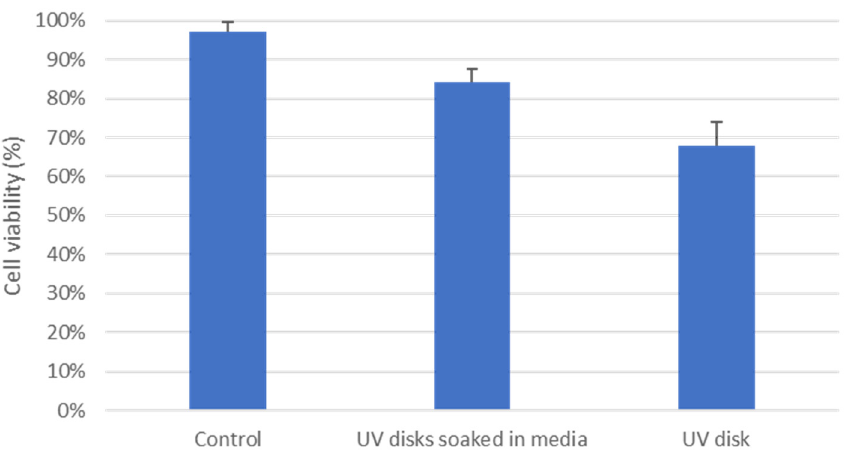
Figure 11. Cell viability evaluation for control, UV disks soaked in media and UV disks.